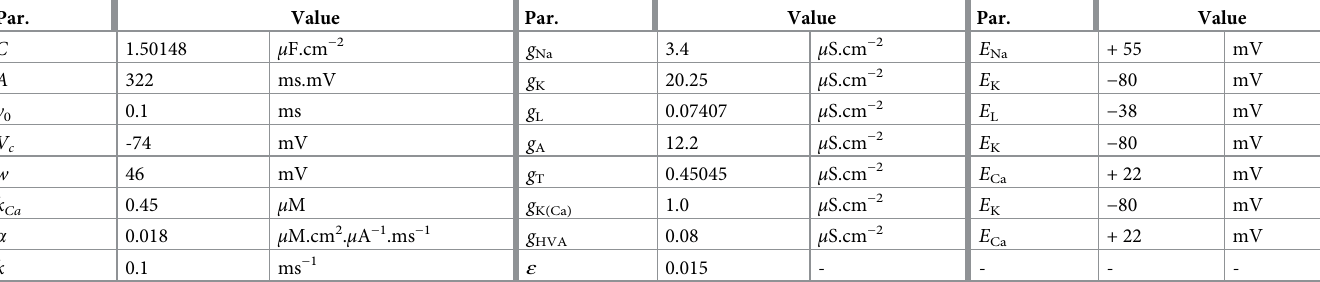
Table 2. Parameter values of the full system (1) that do not change during runup while exhibiting tonic firing.